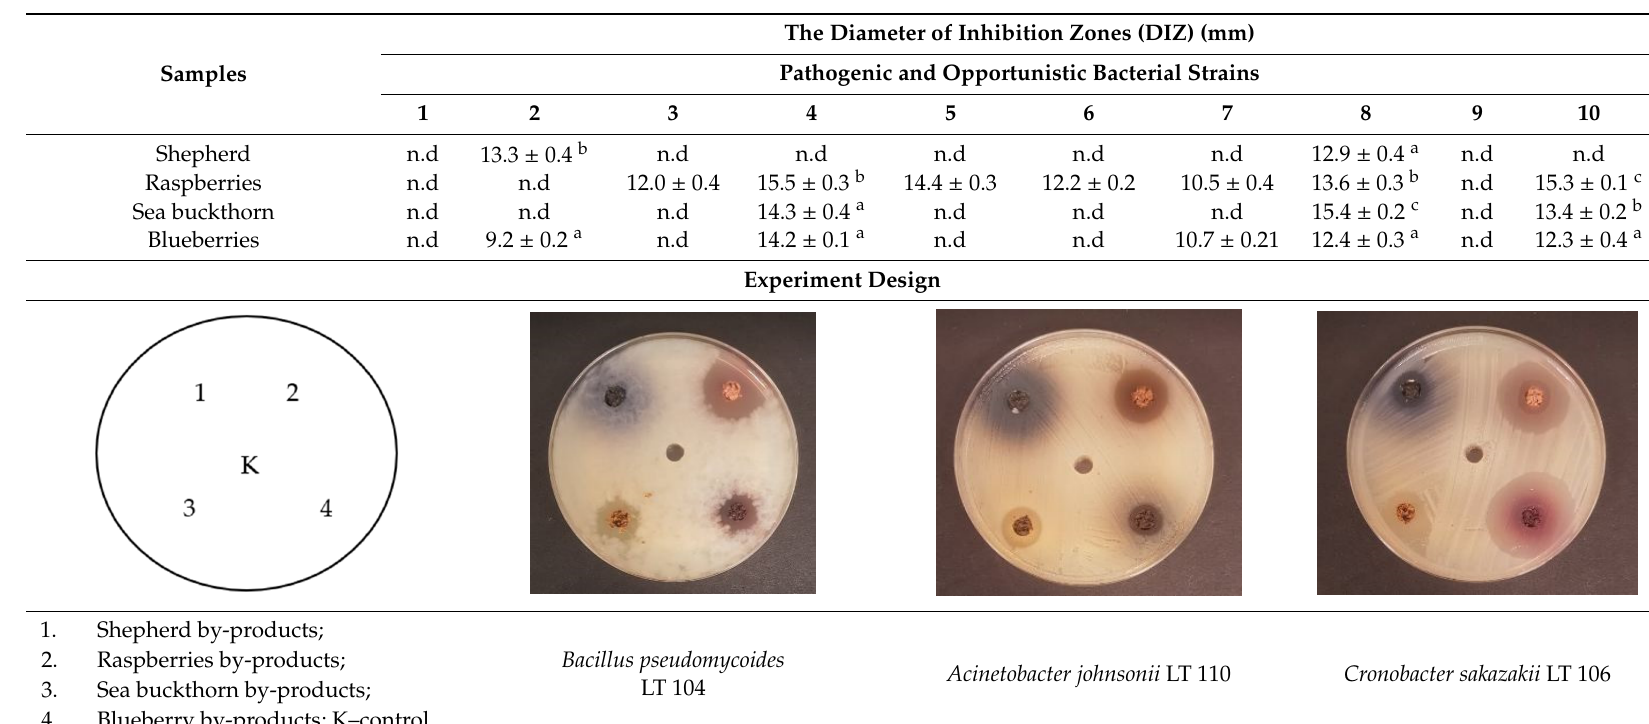
Table 5. Antimicrobial properties of the fruit / berry by-products.